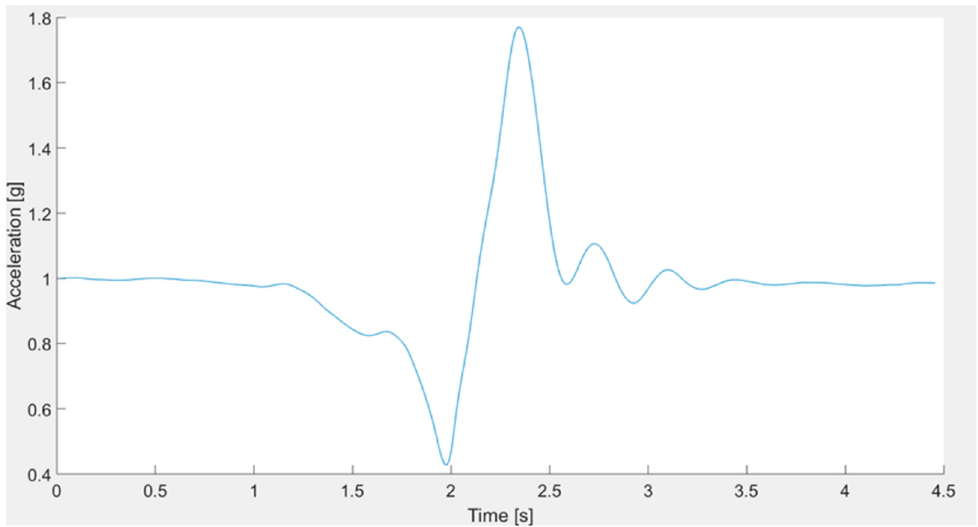
Figure 3. Exemplary SMV characteristics for the fall test.